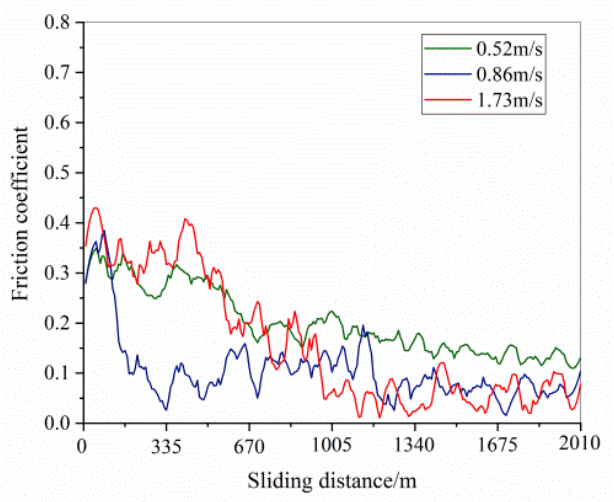
Figure 4. The change curves of the friction coefficients of SN20/PEEK as a function of friction distance.